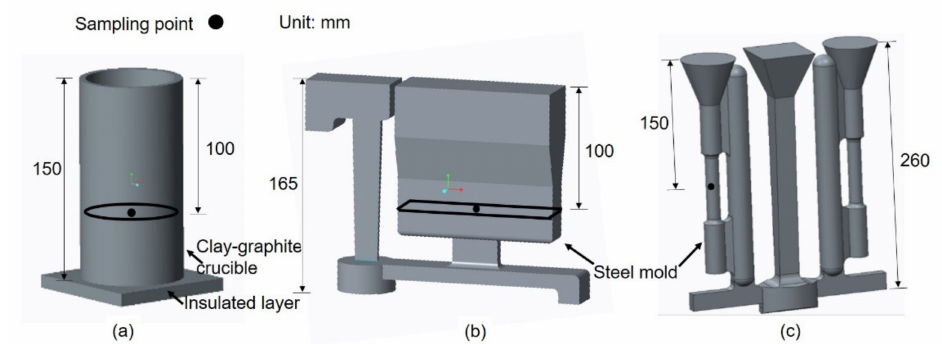
Figure 1. Schematic diagram of ( a ) clay-graphite crucible, ( b ) castings for self-design permanent mold, and ( c ) castings for ASTM B-108 permanent mold used in gravity die casting.